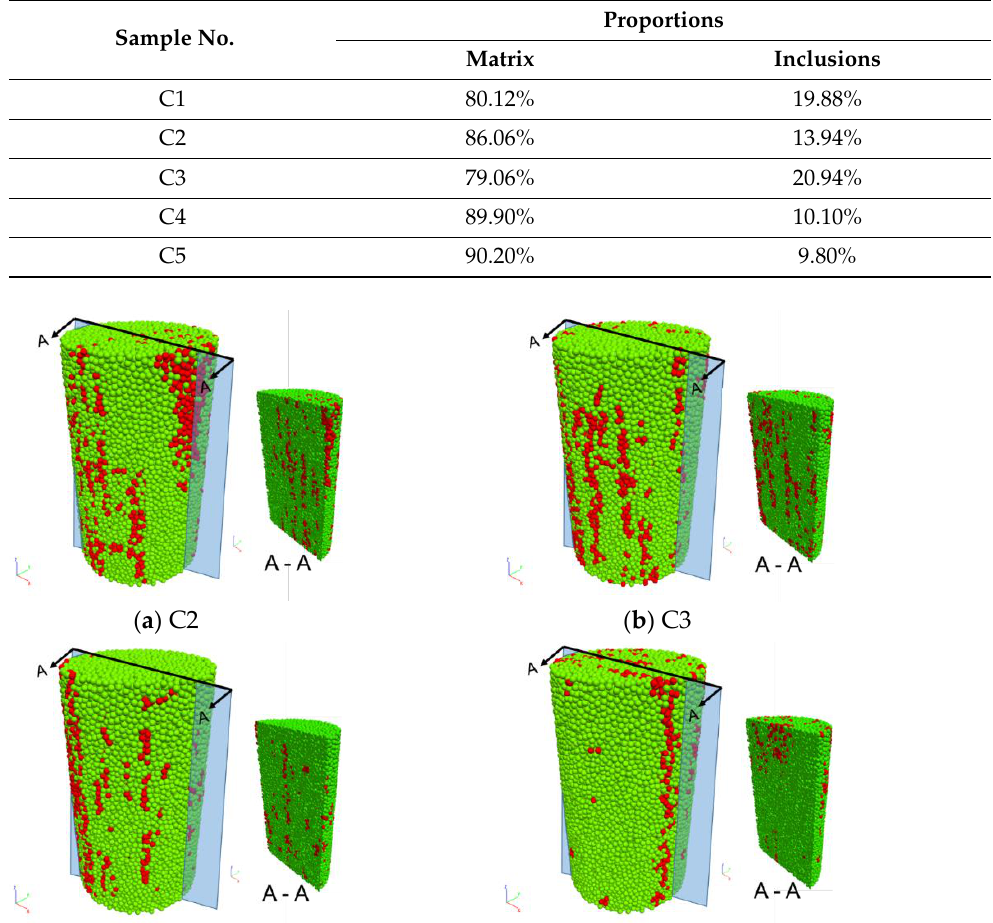
( b ) Figure 4. Particle-based ( a ) and corresponding continuum-based ( b ) model C1 (green: matrix; red: inclusions; holes: pores). 3. Permeability Test under Triaxial Compression The permeability evolution of coal samples is investigated via triaxial fluid-mechan- ical coupled tests (Karman type) arranged for steady-state flow. The tests are conducted at a room temperature of 20 ± 3 °C. A stiff servo-controlled loading device is used to apply axial load and confining pressure. The cylindrical sample has been sheathed by a polyvi- nyl chloride (PVC) core sleeve. Sample and axial platens are isolated from the confining fluid by the core sleeve. The gas used in this experimental research is pure nitrogen. Its viscosity is 1.78 × 10 −5 Pa·s at laboratory temperature. The gas migrates through the sample without leakage. The system is supported by professional control software packages, such as Test-Star-II Control System and Test-Ware from MTS. The entire set-up of the test is shown in Figure 5.